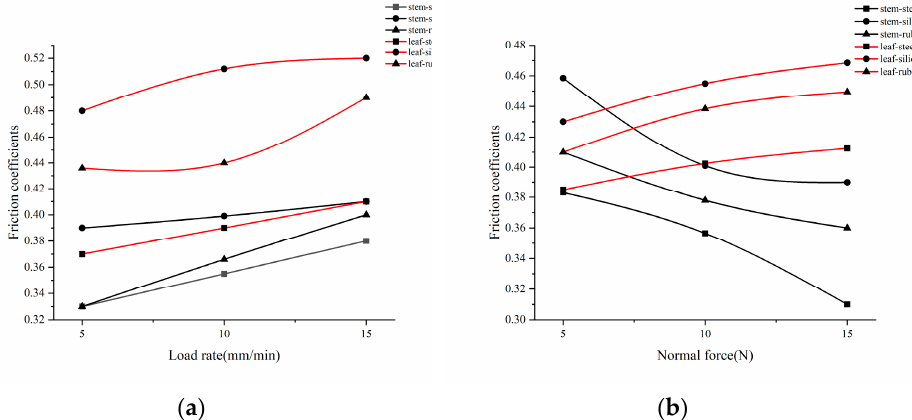
Figure 24. Friction coefficient between wakame stem and leaf and different contact materials. ( a ) Friction coefficient between wakame stem and leaf and different contact materials under different loading rates; ( b ) Friction coefficient between wakame stem and leaf and different contact materials under different normal